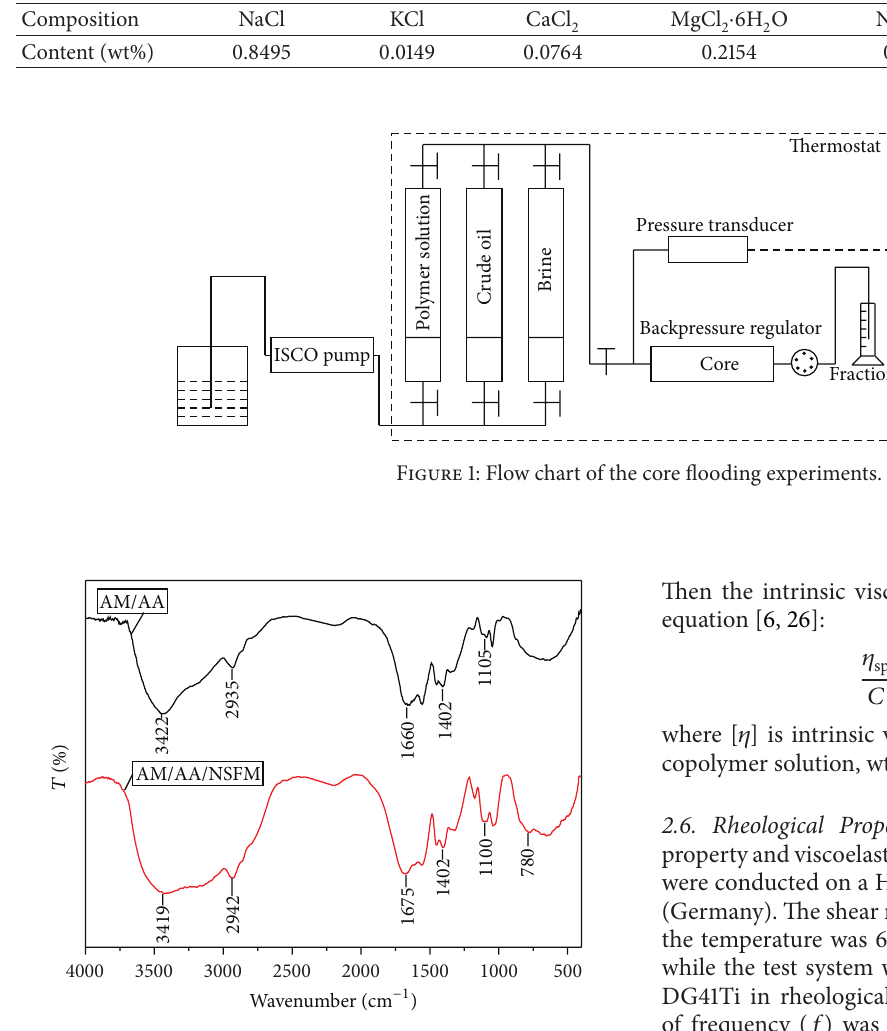
Figure 2: IR spectra of AM/AA and AM/AA/NSFM.